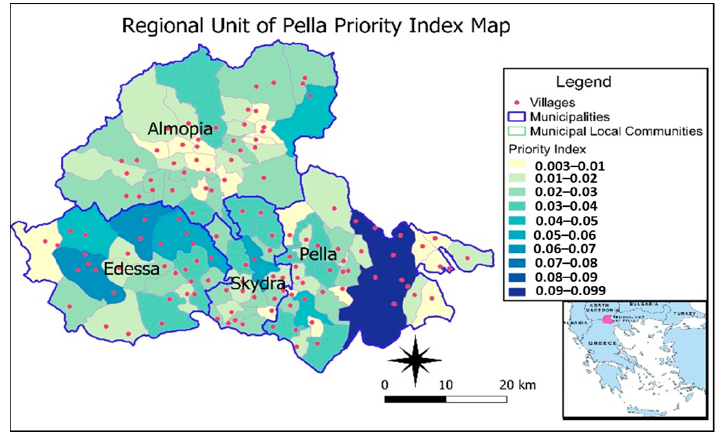
Figure A2. Graded Dependence Map (RDI).